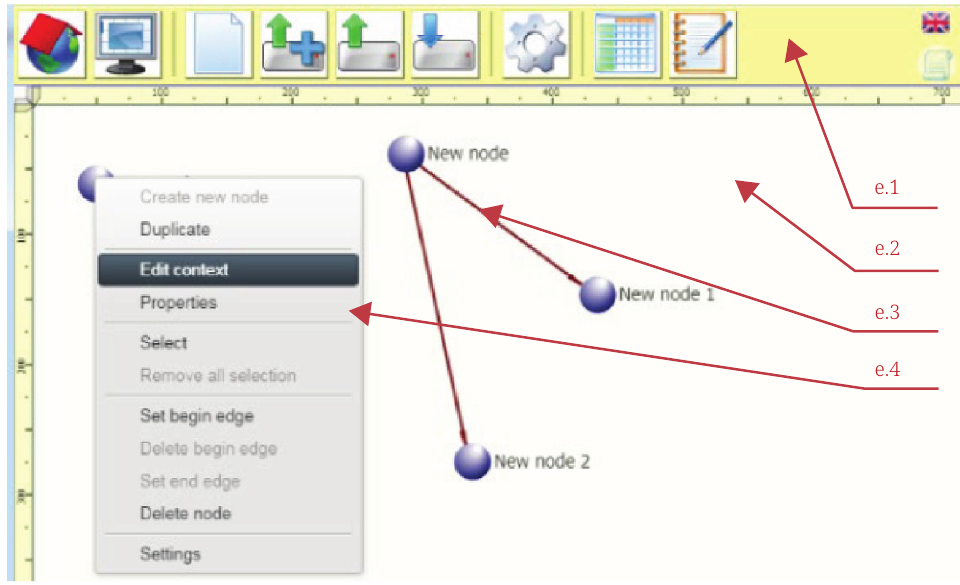
Fig. 2. ONTOS web resource (http://ontos.xyz/)